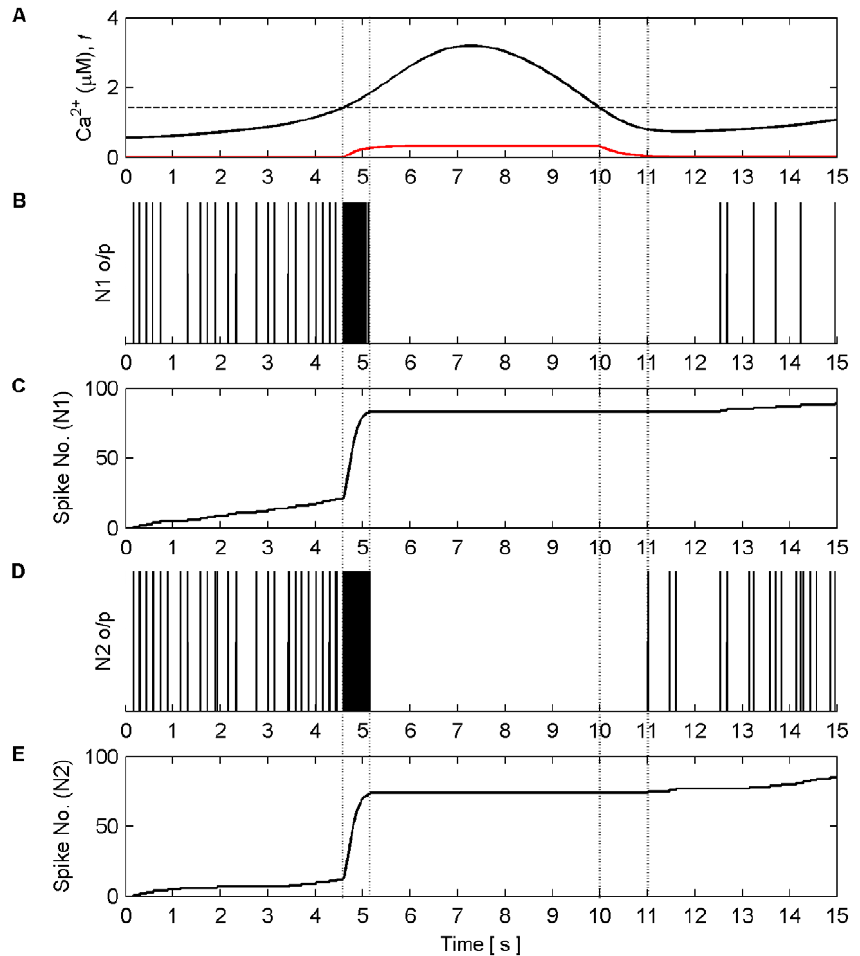
Figure 11. Coordinated firing activity of N1 and N2 for the first 15 s of AN model simulation. (A) The aggregate level of Ca 2 + (black line) and gating function f (red line). (B) and (D) firing activity of N1 and N2. (C) and (E) firing activity of N1 and N2 plotted as number of output spikes against time. When the level of Ca 2 + crosses the threshold (1 st vertical dashed line) SIC stimulates all synapses causing each neuron to burst for approximately 600 ms (2 nd vertical dashed line). During this time the gating function f depresses neurotransmitter release from all synapses, during which the neurons are held silent as a result of decreased neurotransmitter release, until the Ca 2 + level crosses the threshold from above (3 rd vertical dashed line) after which it takes approximately 1 s for the gating function to fully stop synaptic depression (4 th vertical dashed line). When this period ends the neuron can again fire as the synapses are releasing transmitter fully.